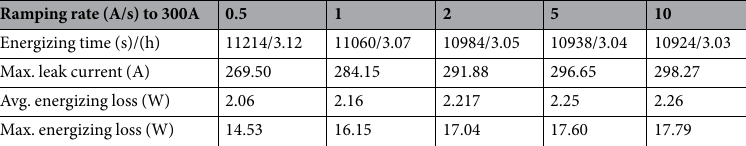
Table 2. Energizing characters of the HTS magnets.